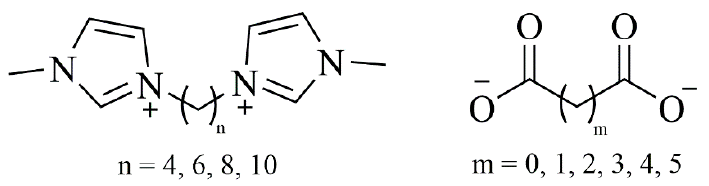
Figure 1. Molecular structure of dicationic ionic liquids.